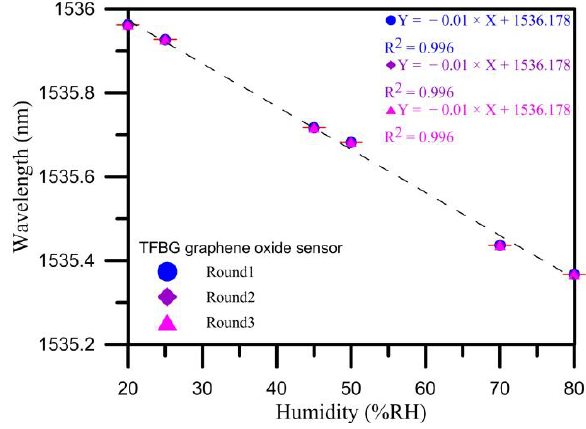
Figure 9. Comparison of sensitivity of TFBG humidity sensors with different diameters.